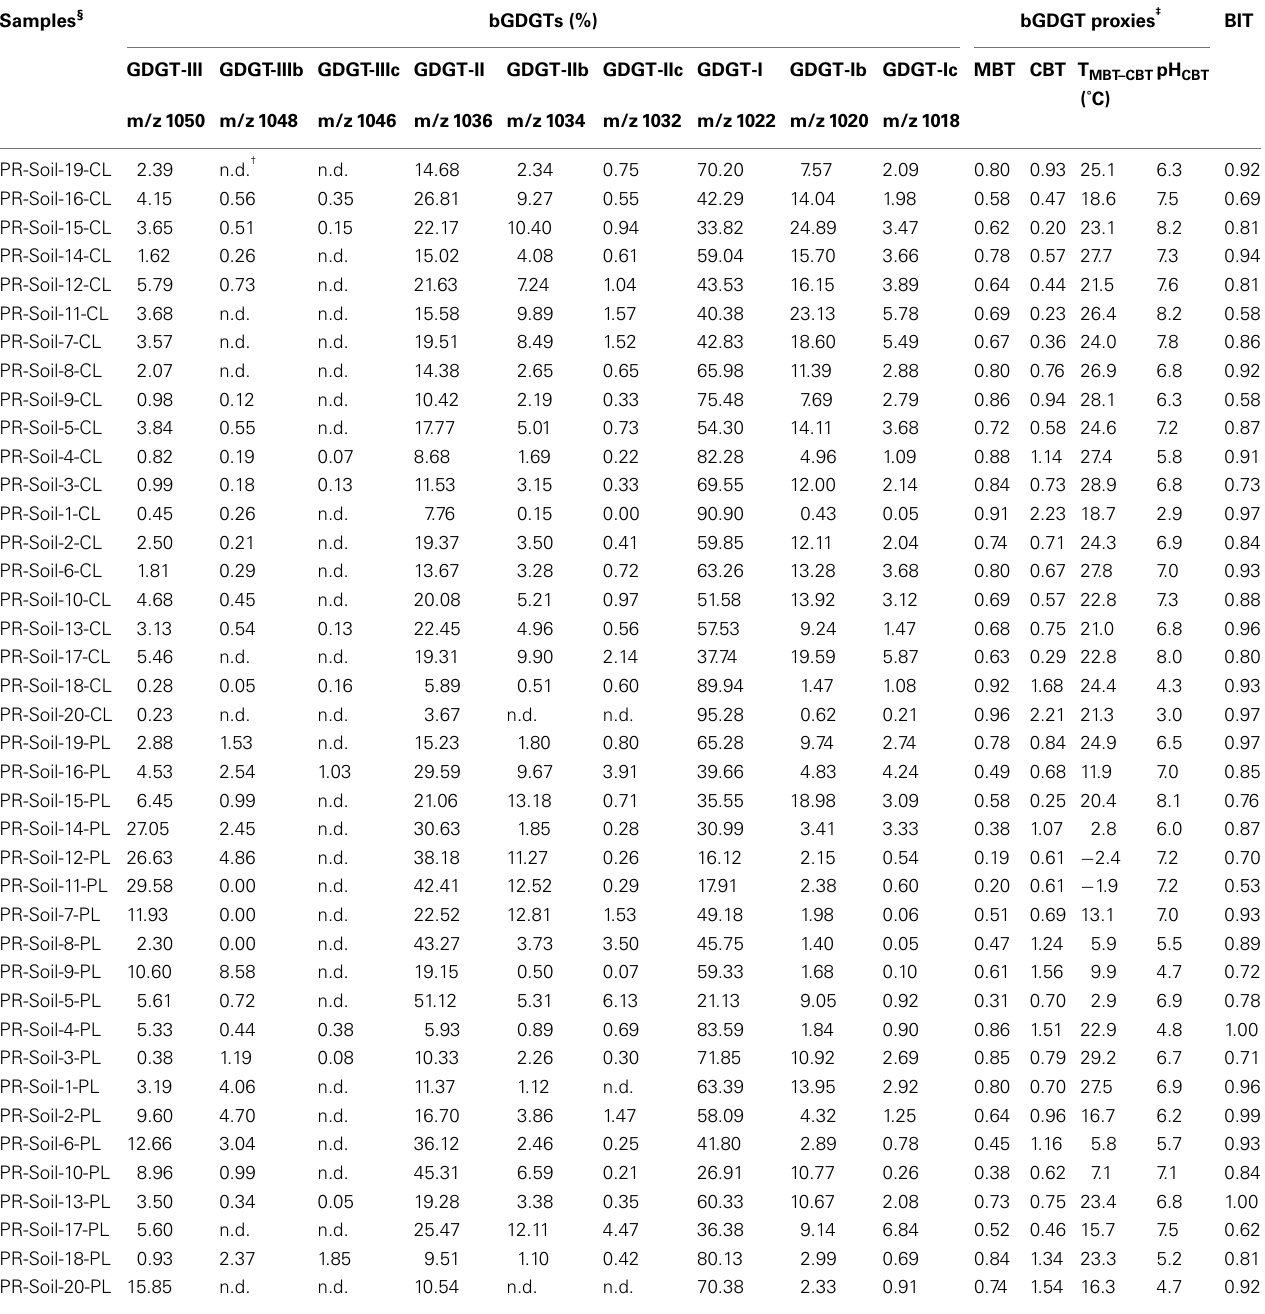
TableA3 | Sonication extraction-derived bGDGTs and proxies for soil samples. Samples